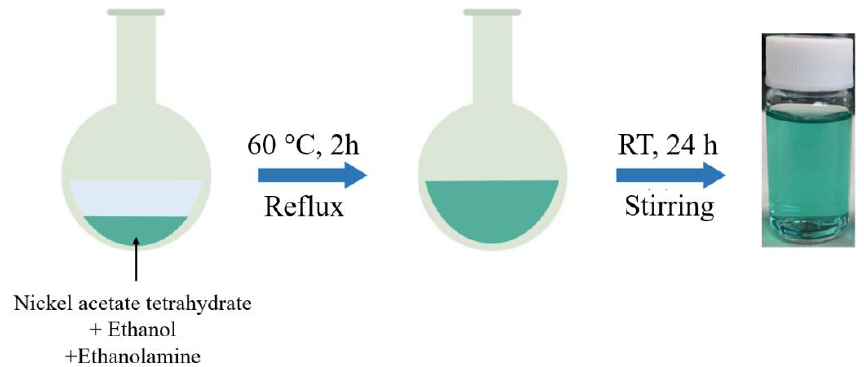
Figure 1. Schematic of the synthesis of NiO precursor with the sol–gel method.